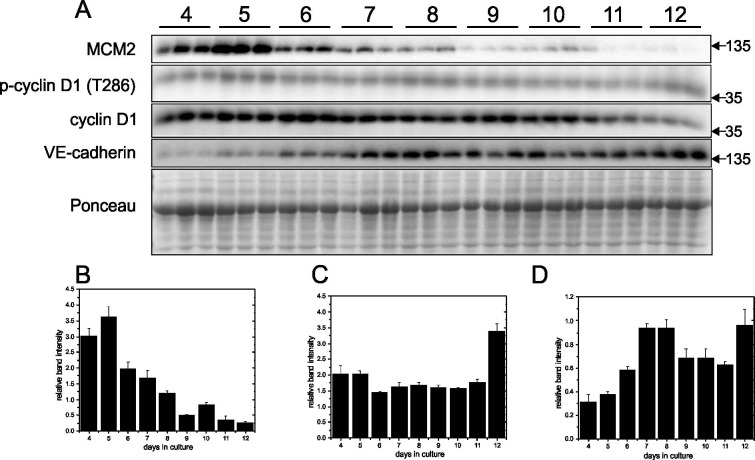
Time course for MCM2, p-cyclinD1, cyclin D1 and VE-cadherin in EA.hy926 cells grown on plastic culture plates.EA.hy926 endothelial cells were seeded on plastic plates at 9000 cells/cm2 and grown for 12 days. Protein levels of MCM2, p-cyclinD1, cyclin D1 and VE-cadherin were determined by Western blotting of cell lysates prepared each day from day 4 to day 12. Representative blots are shown in Panel A. Densitometry was used to quantify the intensity of the bands in the upper panel and data were normalized to a band visualized by Ponceau staining. Data are presented as means ± SEM (n = 3) for MCM2 (Panel B), p-cyclin D1/cyclin D1 (Panel C) and VE-cadherin (Panel D).